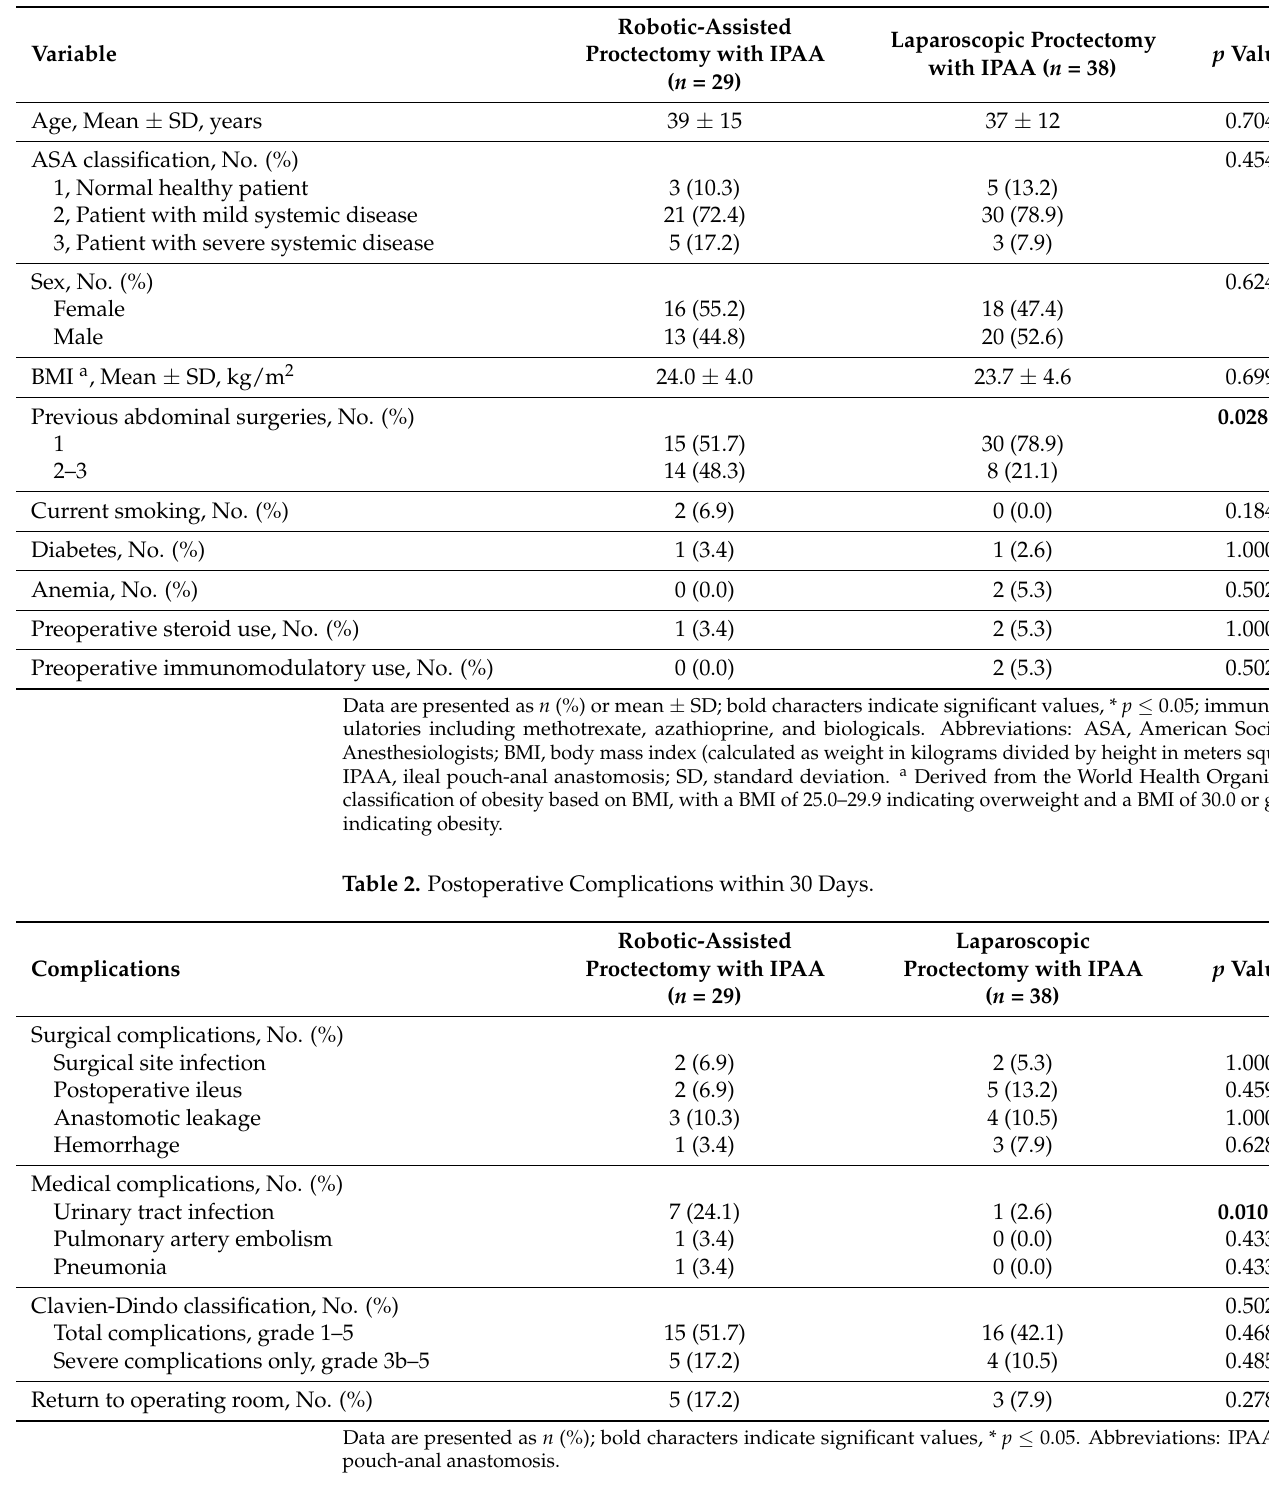
Table 1. Patient Baseline Characteristics.